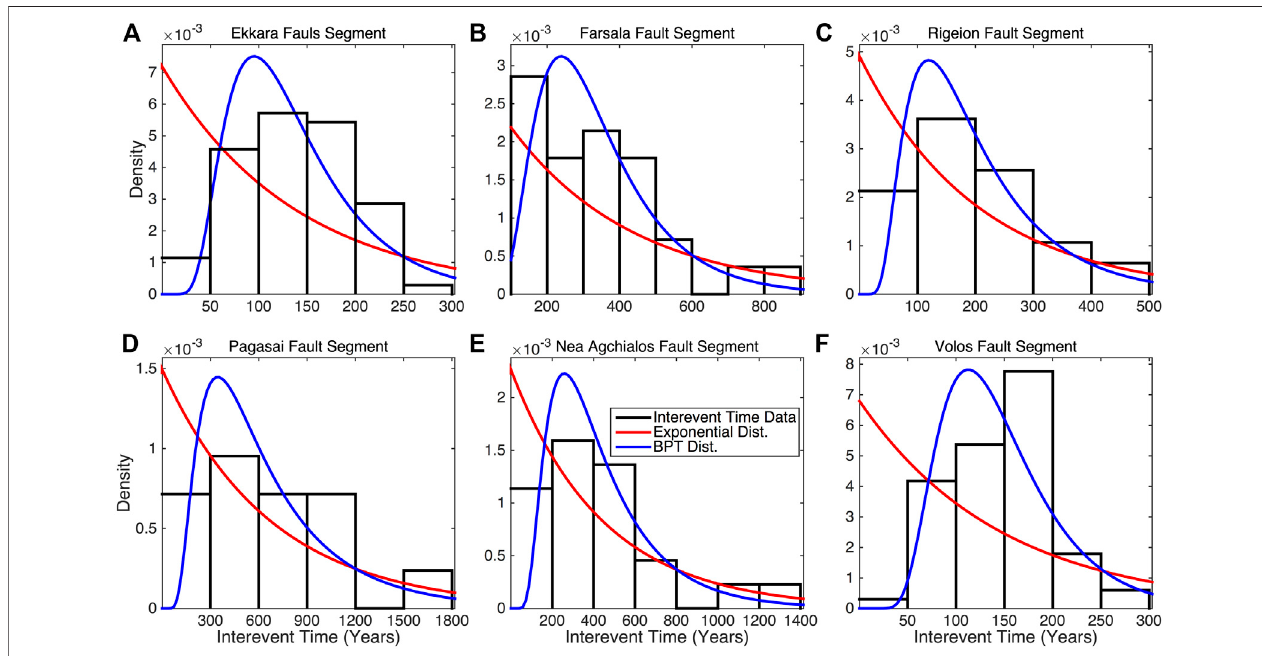
FIGURE9| ProbabilitydensityfunctionsofPoisson(redline)andBPT(blueline)modelsfortheintereventtimesofstrongearthquakeswith M thr ≥ 6.0fortheEkkara (A) , Farsala (B) , Rigeion (C) , Pagasai (D) , Nea Agchialos (E) , and Volos (F) fault segments. Black boxes indicate the density values of each bin of interevent times.